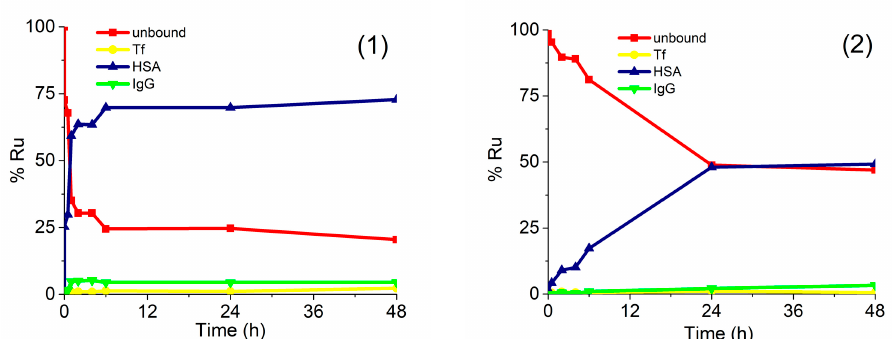
Figure 5. Kinetics of binding of complexes ( 1 ) and ( 2 ) to serum proteins. Human serum was spiked with complex ( 1 ) (0.760 µ g / mL Ru) or ( 2 ) (0.396 µ g / mL Ru). For separation of Ru species in 5-times diluted serum samples CLC monolithic column was used. Their separation was followed by the UV spectrometry at 278 nm and post-column ID-ICP-MS detection.